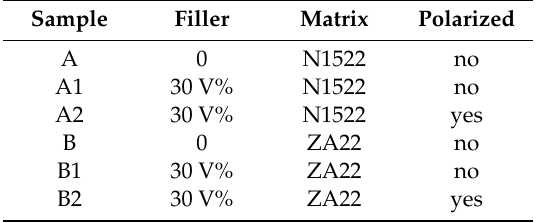
Table 1. Composition and polarizable character of the magnetorheological elastomer (MRE) composites.